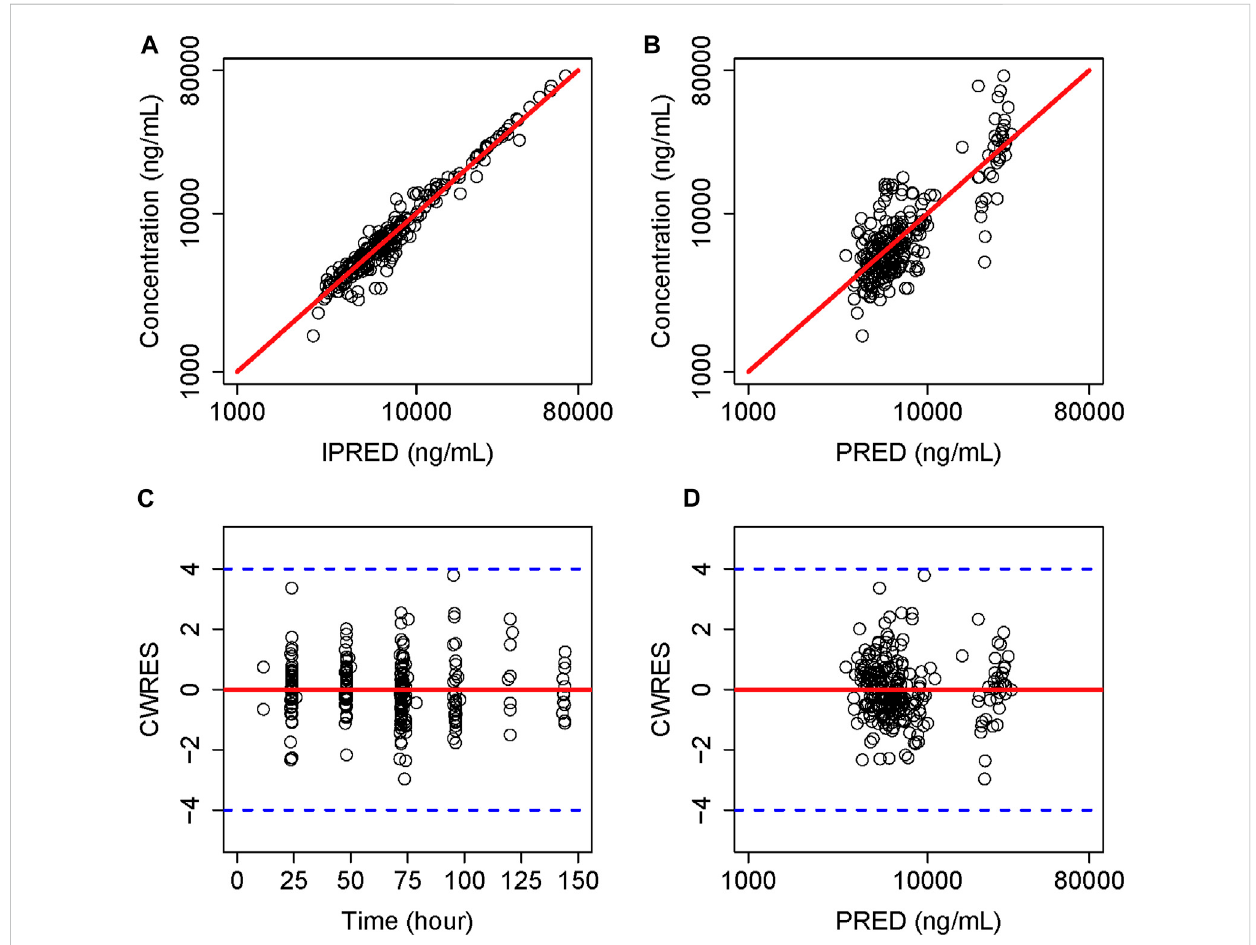
FIGURE 1 Goodness-of- fi t plot of the fi nal model. (A) Individual predicted concentration versus observed concentration. (B) Population predicted concentration versus observed concentration. (C) Conditional weighted residuals versus time. (D) Conditional weighted residuals versus population predicted concentration. The red lines in (A,B) represent the regression line, while the solid red lines in (C,D) indicate the position where conditional weighted residual equals